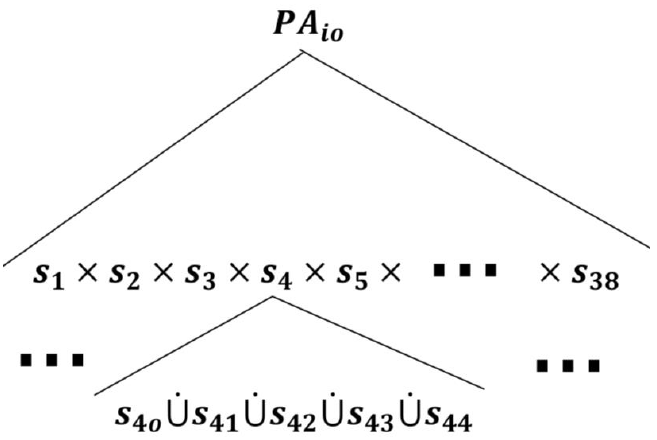
Figure 5. Represents the state space topology of a patient automaton 𝑷𝑨 𝒊𝒐 . Other superstates (𝒔 𝒋 ) can be expanded as shown for 𝑺 𝟒 . We limited the expansion to the components of 𝑺 𝟒 due to space